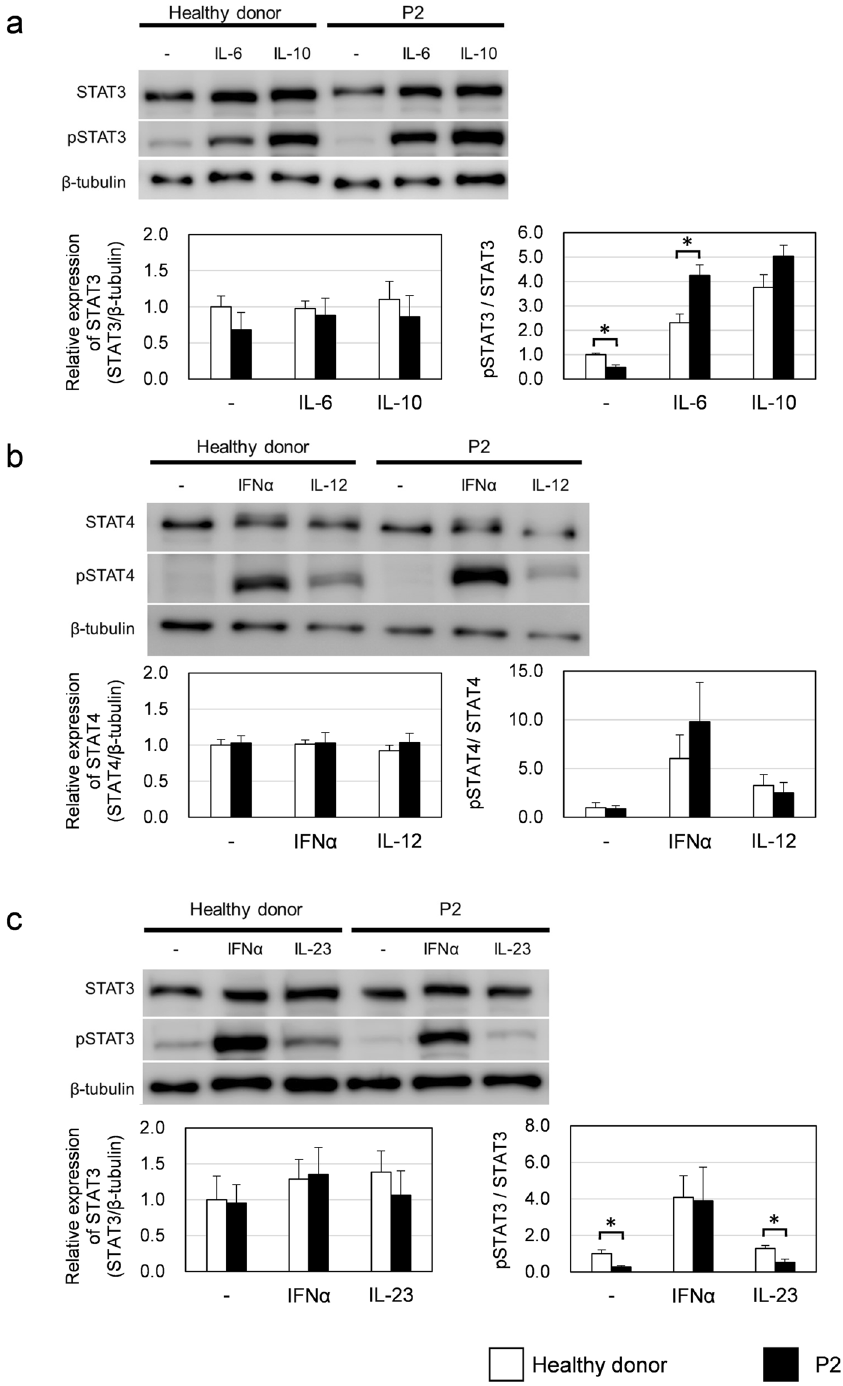
Figure 5. STAT activation in response to IL-6, IL-10, IL-12 and IL-23 in T cells from a healthy donor and the patient.Total STAT and tyrosine-phosphorylated STAT (pSTAT) protein levels were analyzed by western blotting. ( a ) The cells were stimulated with IL-6 (10 ng/mL) or IL-10 (10 ng/mL) for 15 min. ( b ) The cells were stimulated with IL-12 (10 U/mL) or IFN- α (1000 U/mL) for 15 min. ( c ) The cells were stimulated with IL-23 (500 ng/mL) or IFN- α (1000 U/mL) for 15 min. Full-length immunoblots are presented in Supplementary Fig. S8–10. Based on three independent analyses using same batch of CD4 + T cells, STAT proteins and pSTAT proteins expression levels were calculated relative to those of untreated healthy donor-derived cells. Data represent mean ± SEM. * P < 0.05. P values were derived from 2-tailed Student’s